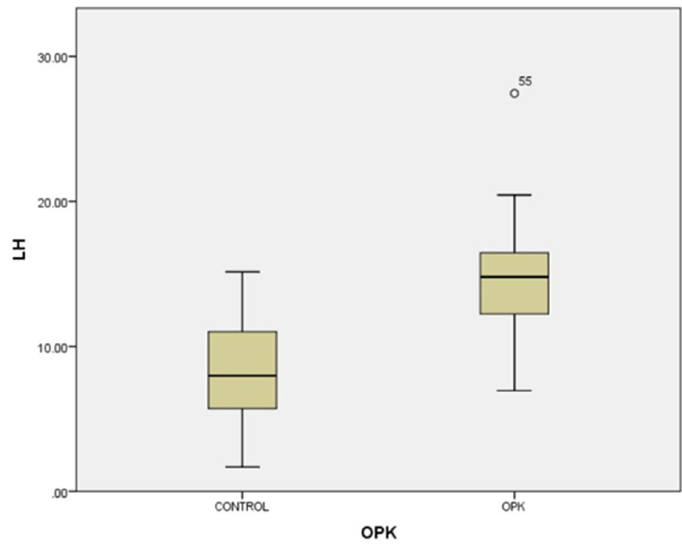
Figure 3. Univariate analysis between body mass index and PCOS ( p < 0.01). Circles represent high potential outliers and the stars represent high extreme values.